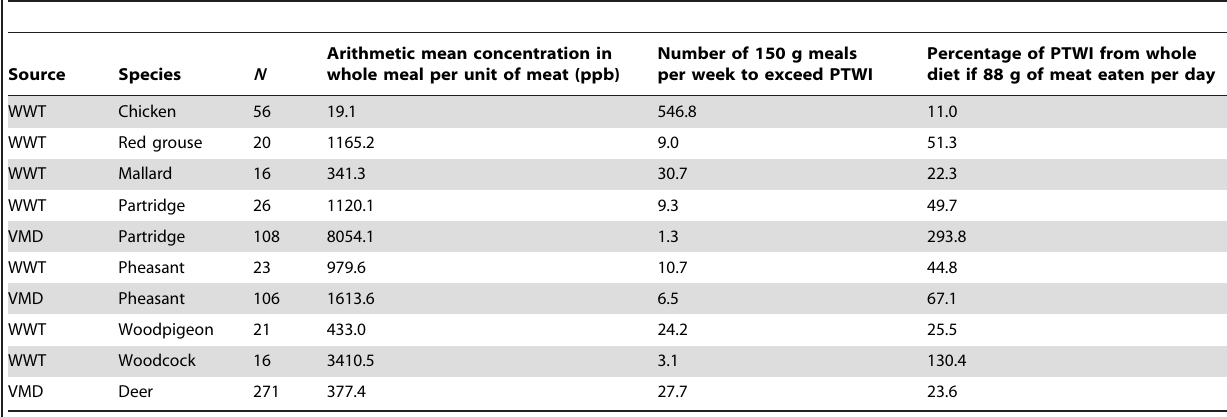
Table 5. Effect on the weekly dietary lead exposure of a 70 kg person of replacing the typical meat component of the diet in the UK with meals of meat of each of several species, including game animals.